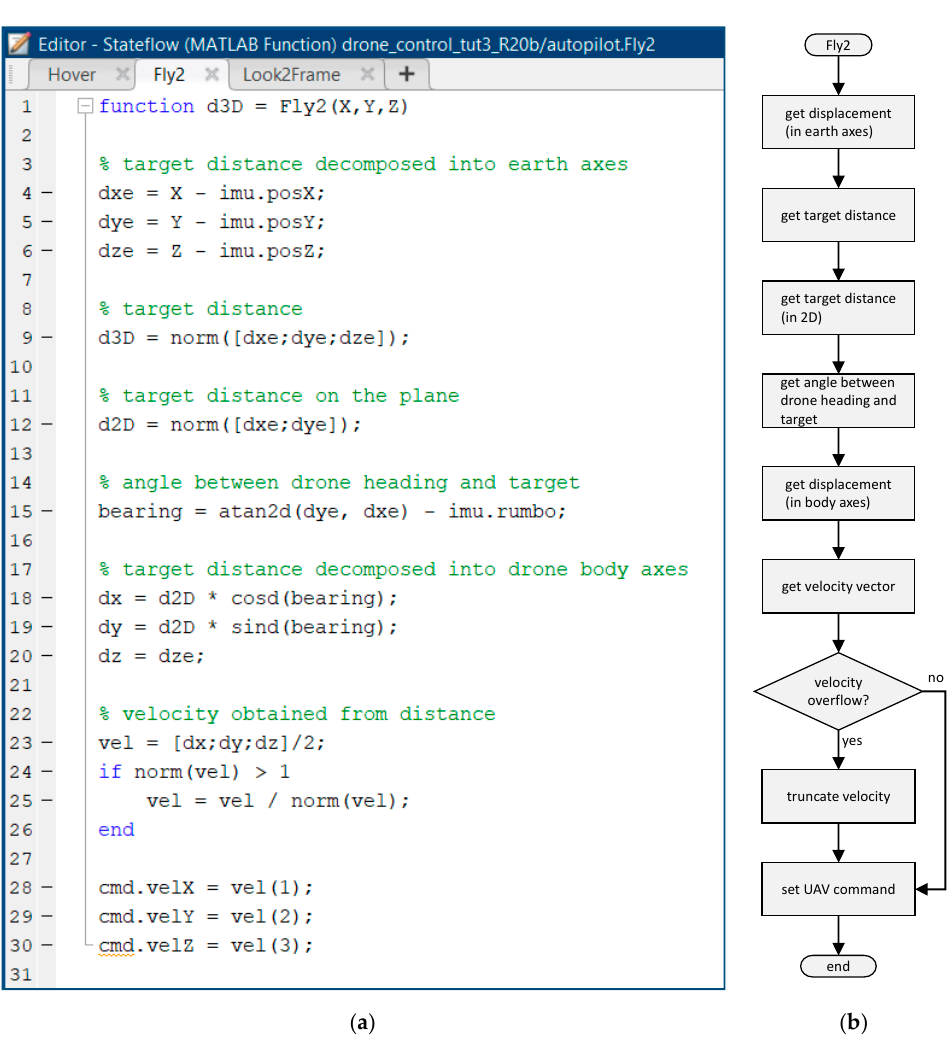
Figure 10. Fly2 MATLAB function defined in Figure 7: ( a ) implementation; ( b ) flow chart. First, the displacement vector e d =